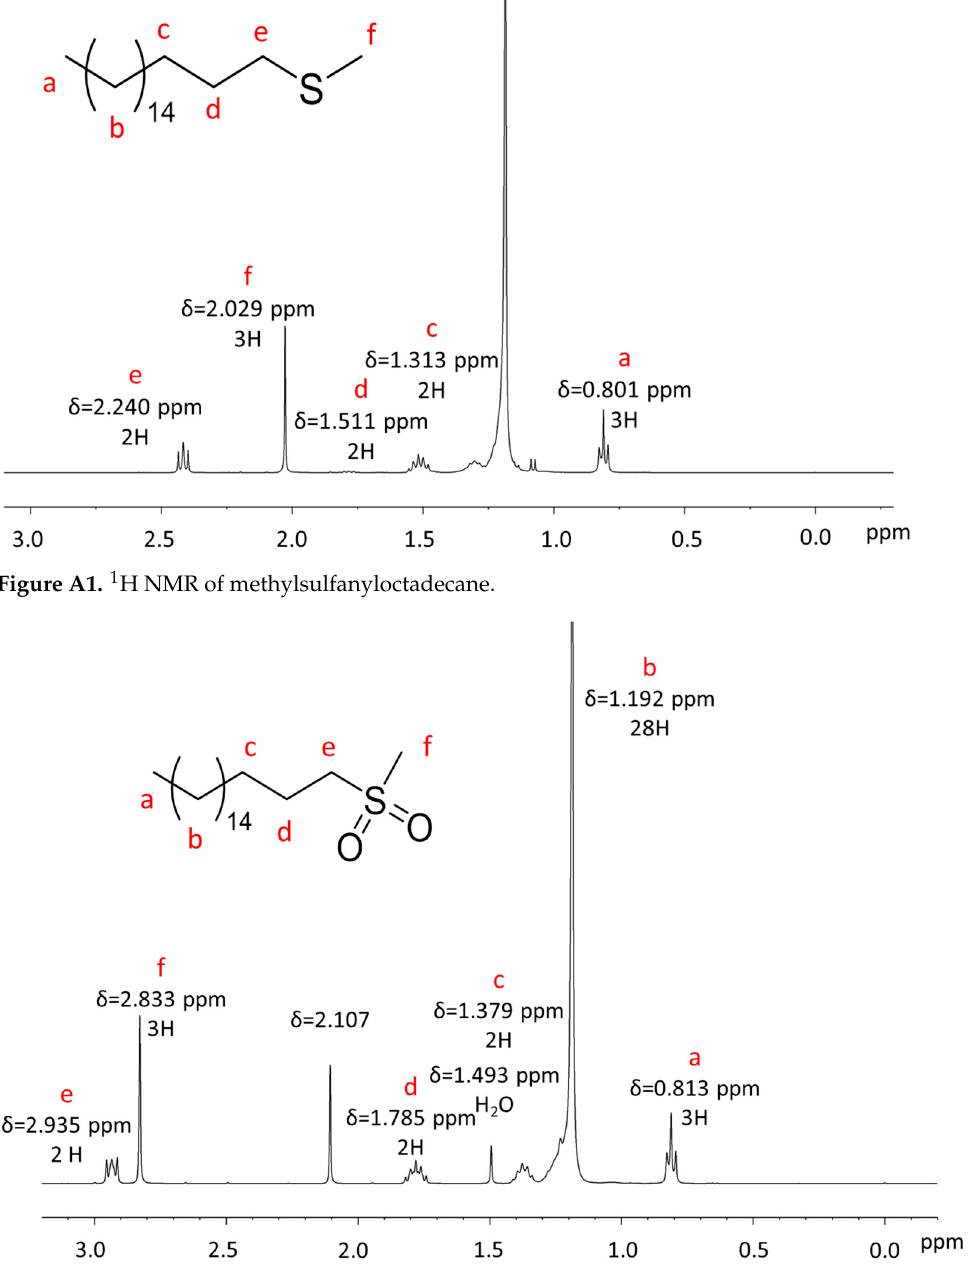
Figure A2. 1 H NMR of methylsulfonyloctadecane.